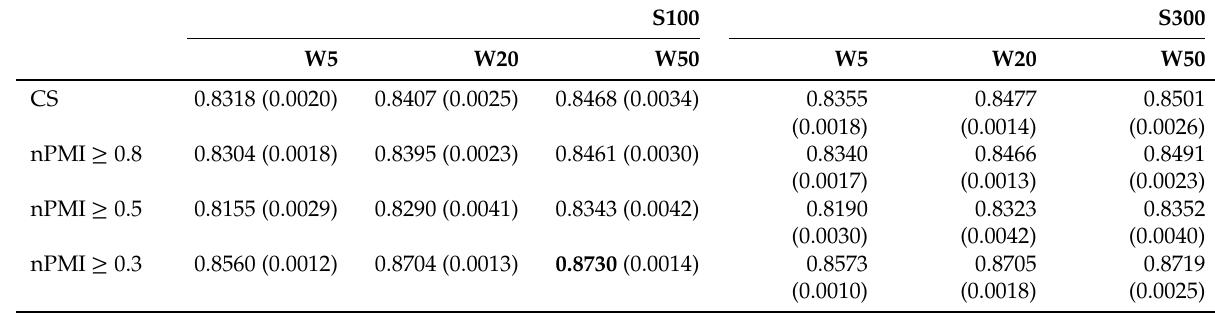
Table 8: Knowledge-based WSD accuracies (standard deviations) using CUI association values (MeSH term co- occurrences), CUI definitions (UMLS), and word